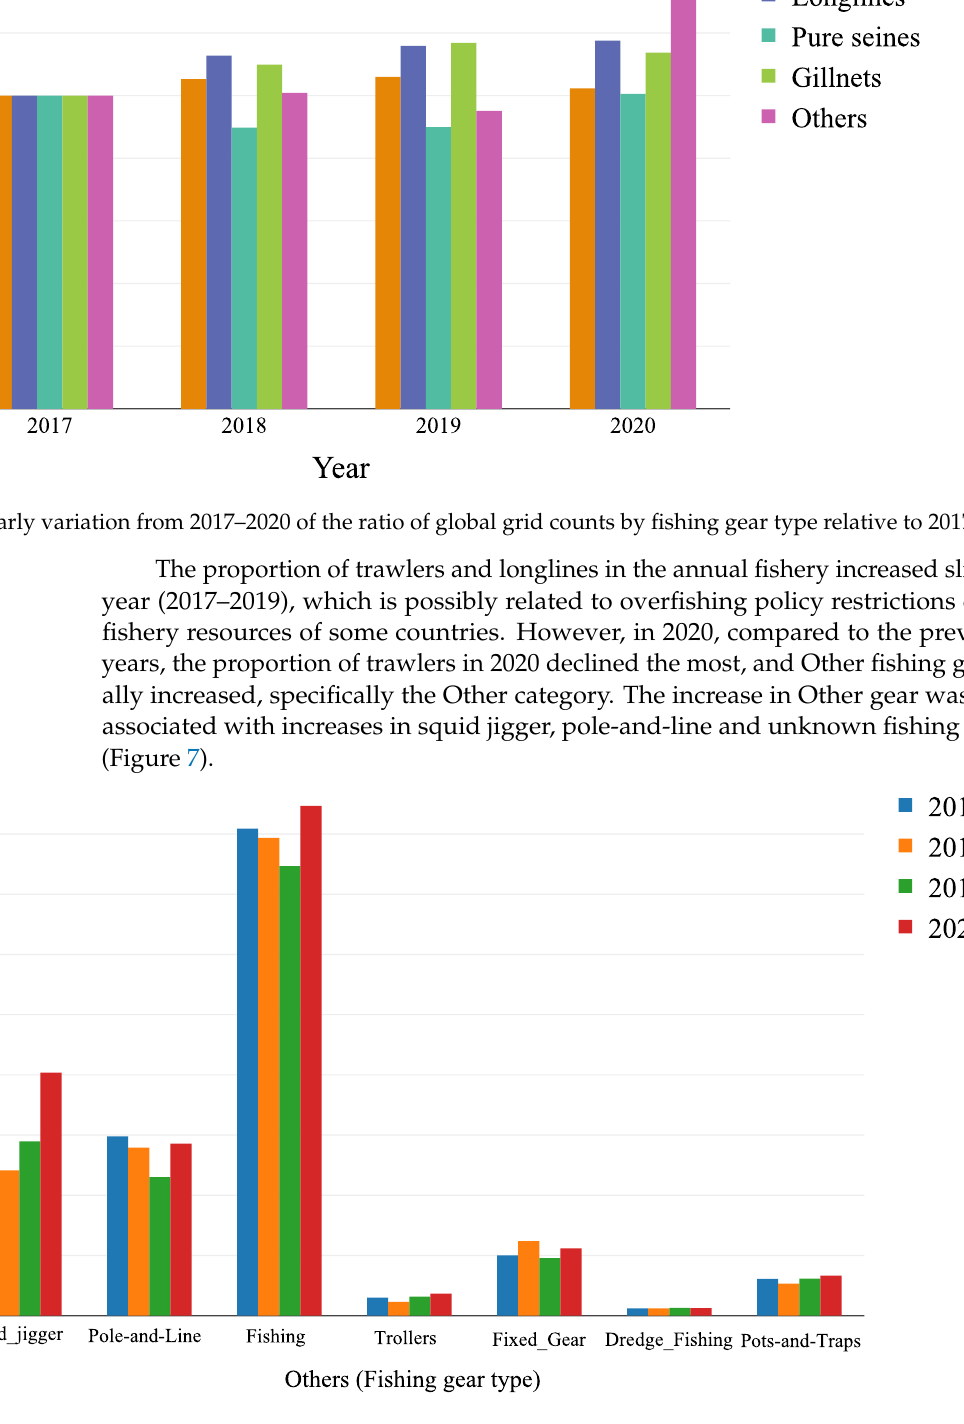
Figure 7. Yearly change in the global grid counts of fishing gear type in the “Other” class of gears.